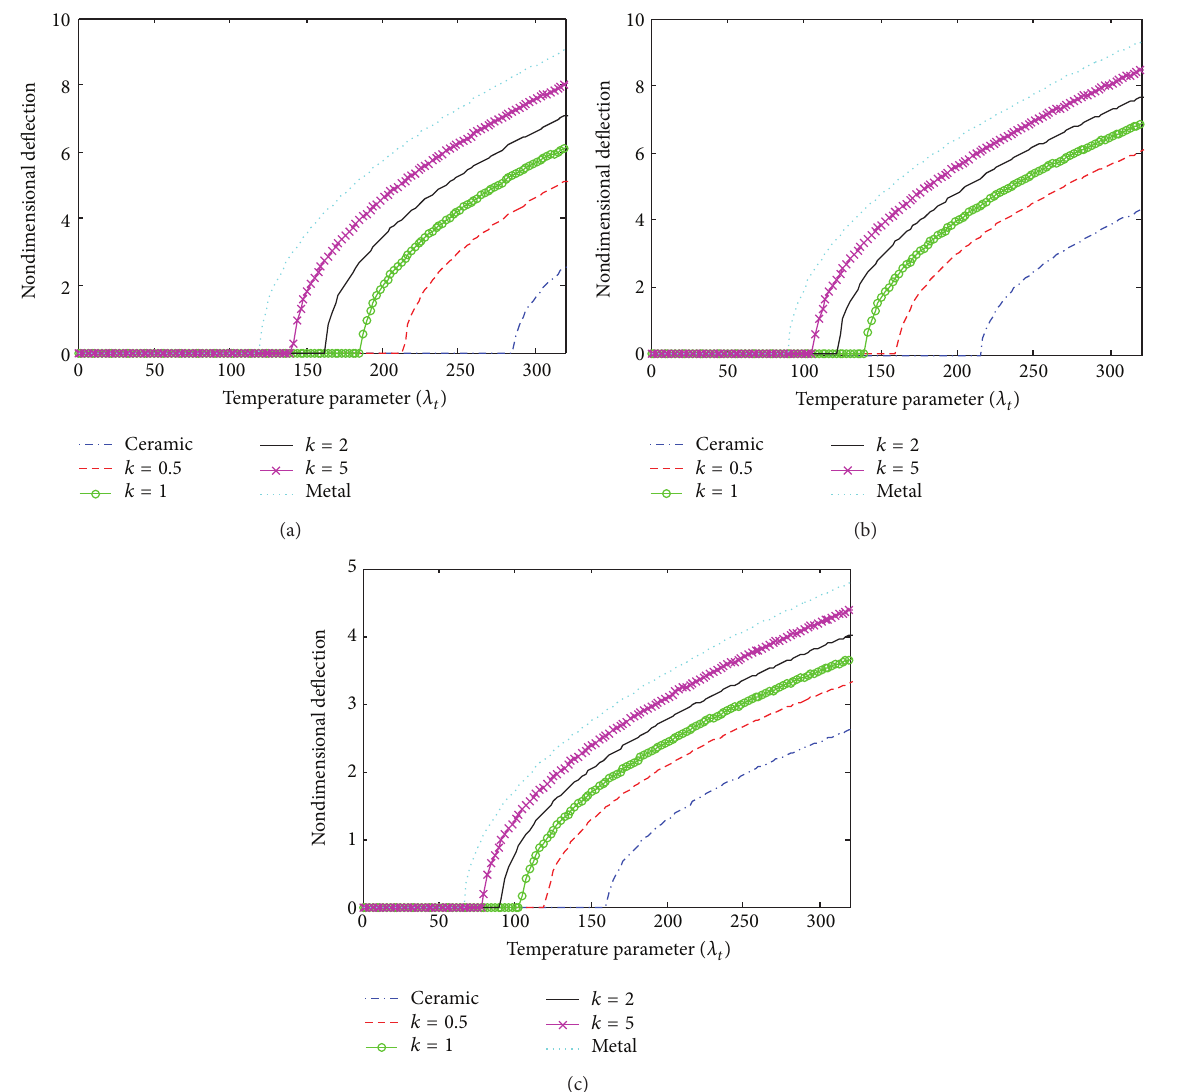
Figure 4: Variation of the nondimensional deflection ( ̂𝑥 = 0.25 ) of (a) clamped-clamped, (b) clamped-simply supported, and (c) simply supported-simply supported FG beam with the temperature parameter for different values of 𝑘 ( 𝑙/ℎ = 1 , 𝐿/ℎ = 40 , third buckling